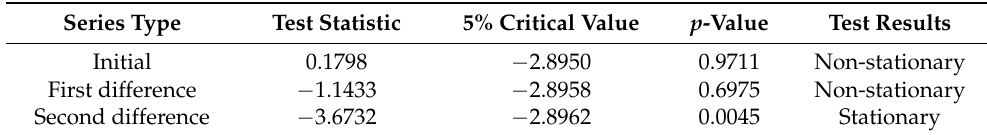
Table 3. ADF test results.